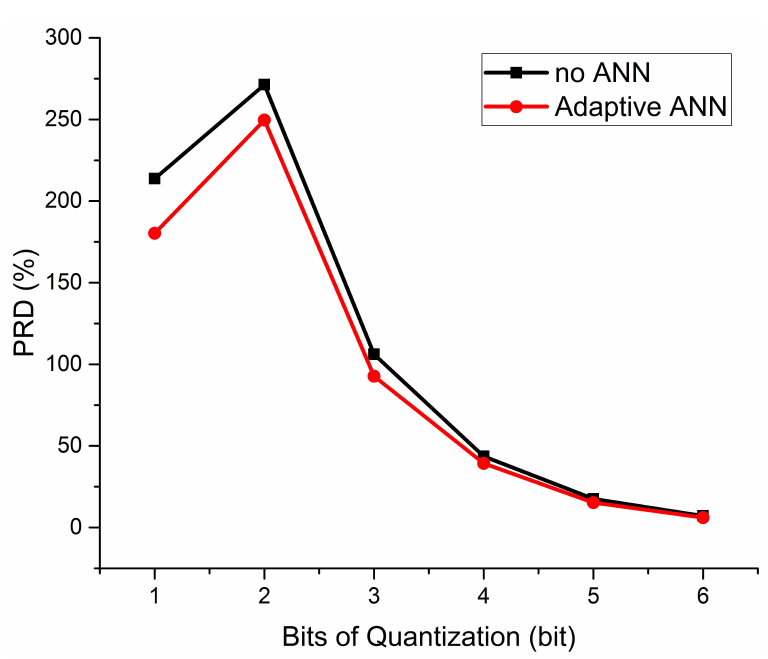
Figure 5. Influence of the presence or absence of adaptive neural